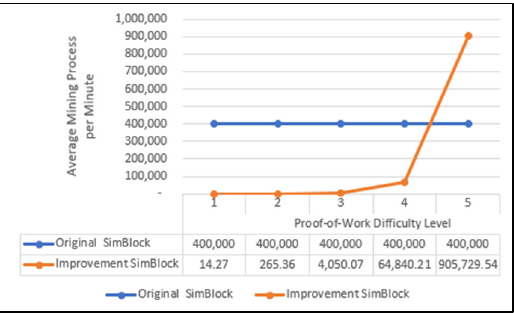
Figure 6. SimBlock mining process comparison.